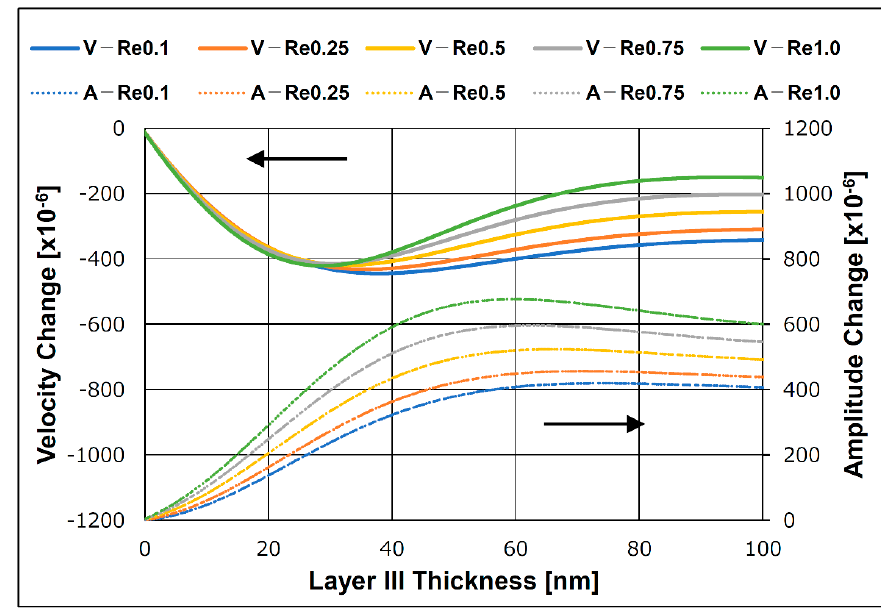
Figure 14. Calculated velocity and amplitude changes.